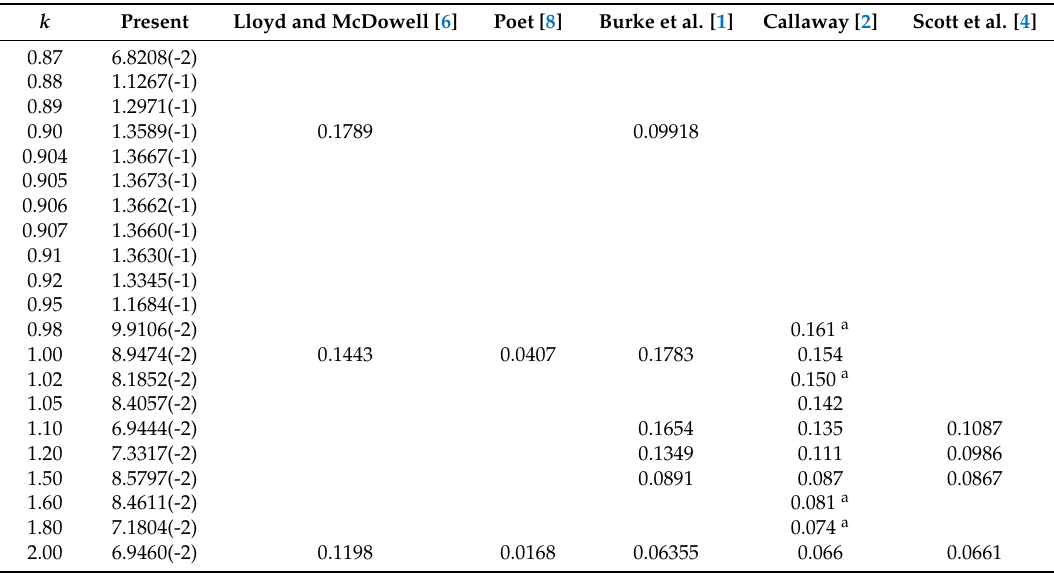
Table 1. Present results ( π a 2 ) for excitation of the 2 S state of atomic hydrogen using the variational 0 polarized orbital method with Lmax = 8 and comparison with the results obtained in references [1,2,4,6,8]. The superscript indicates interpolated